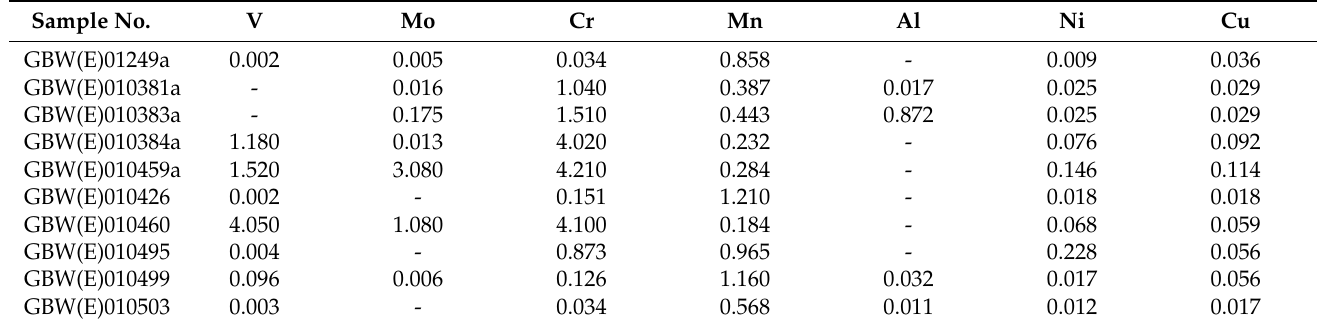
Table 1. List of mass concentrations (wt%) of constituent elements in certified steel alloy samples. Sample No.